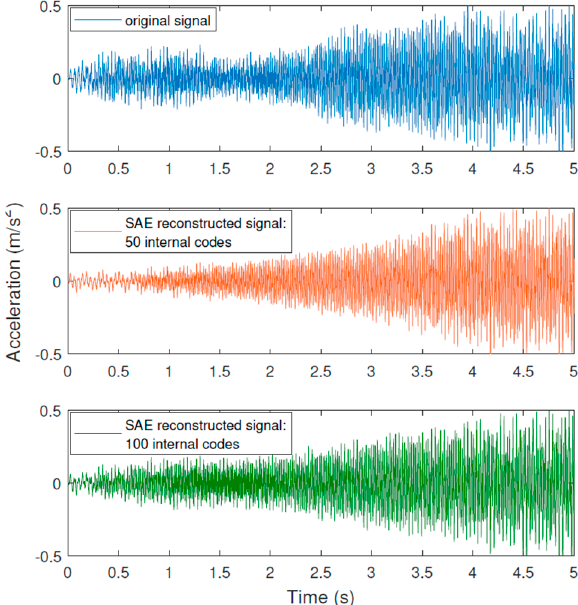
Figure 6. An original response of the numerical beam and its respective signals reconstructed by SAE.